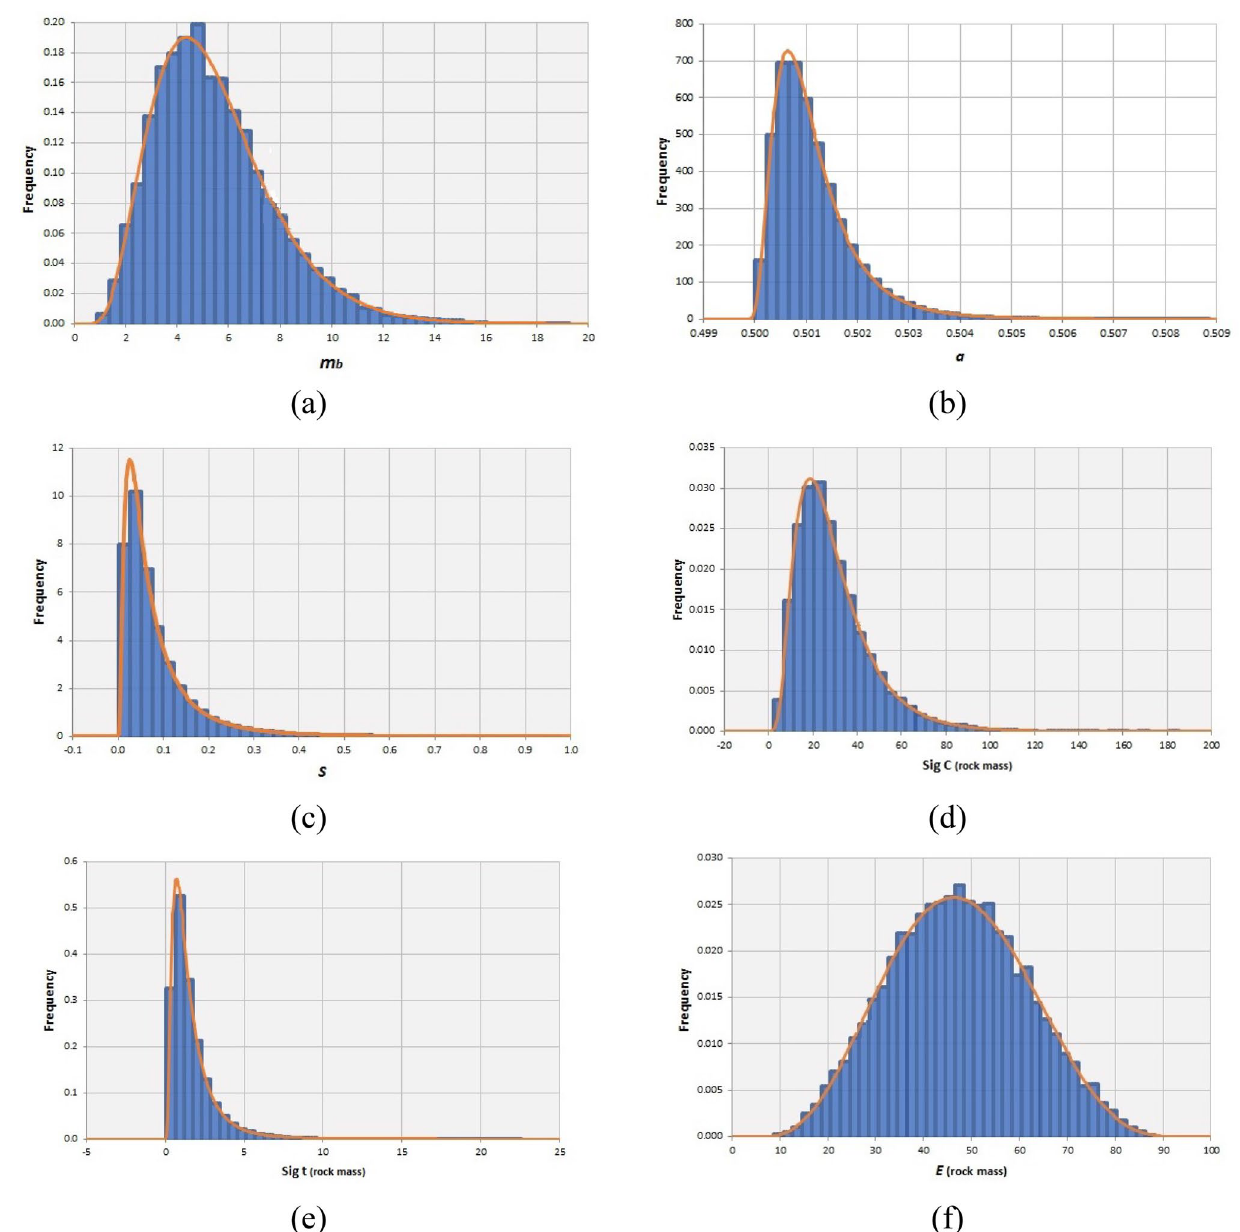
Fig. 11 Histograms and the best-fitted PDF of the geomechanical parameters of the carbonatite-syenite rock